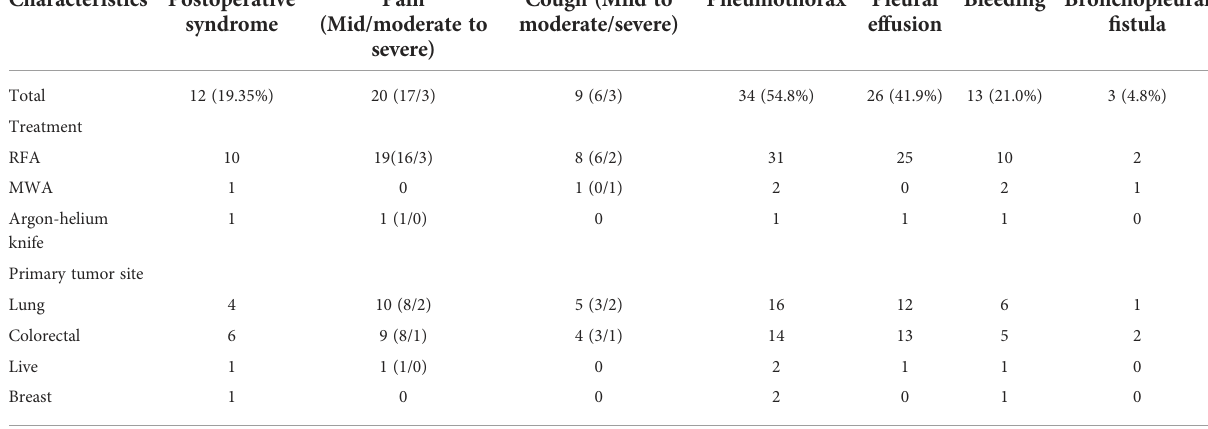
TABLE 3 Incidences of complications and associated factors.